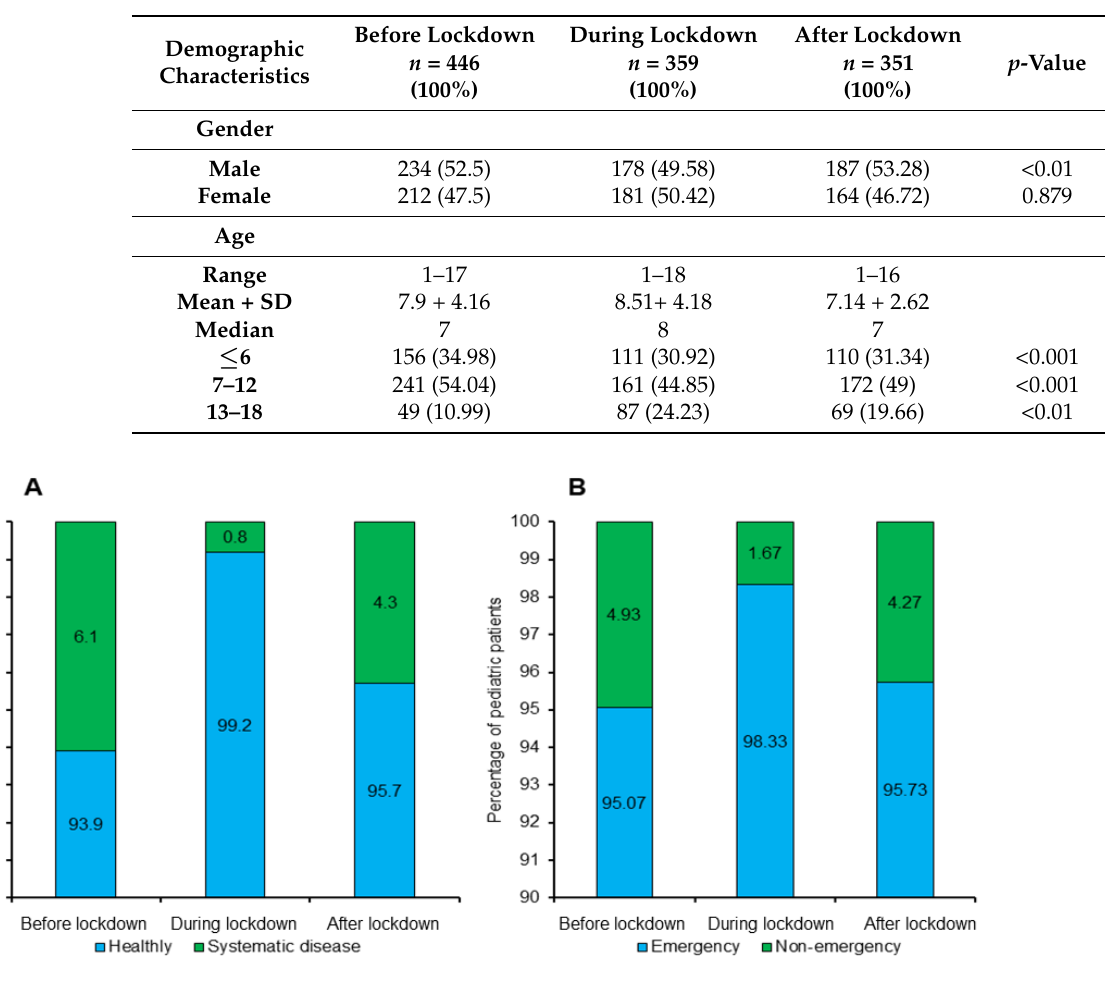
Figure 4. The percentages of pediatric patients’ ( A ) health status and ( B ) visit status before, during, and after the lockdown.